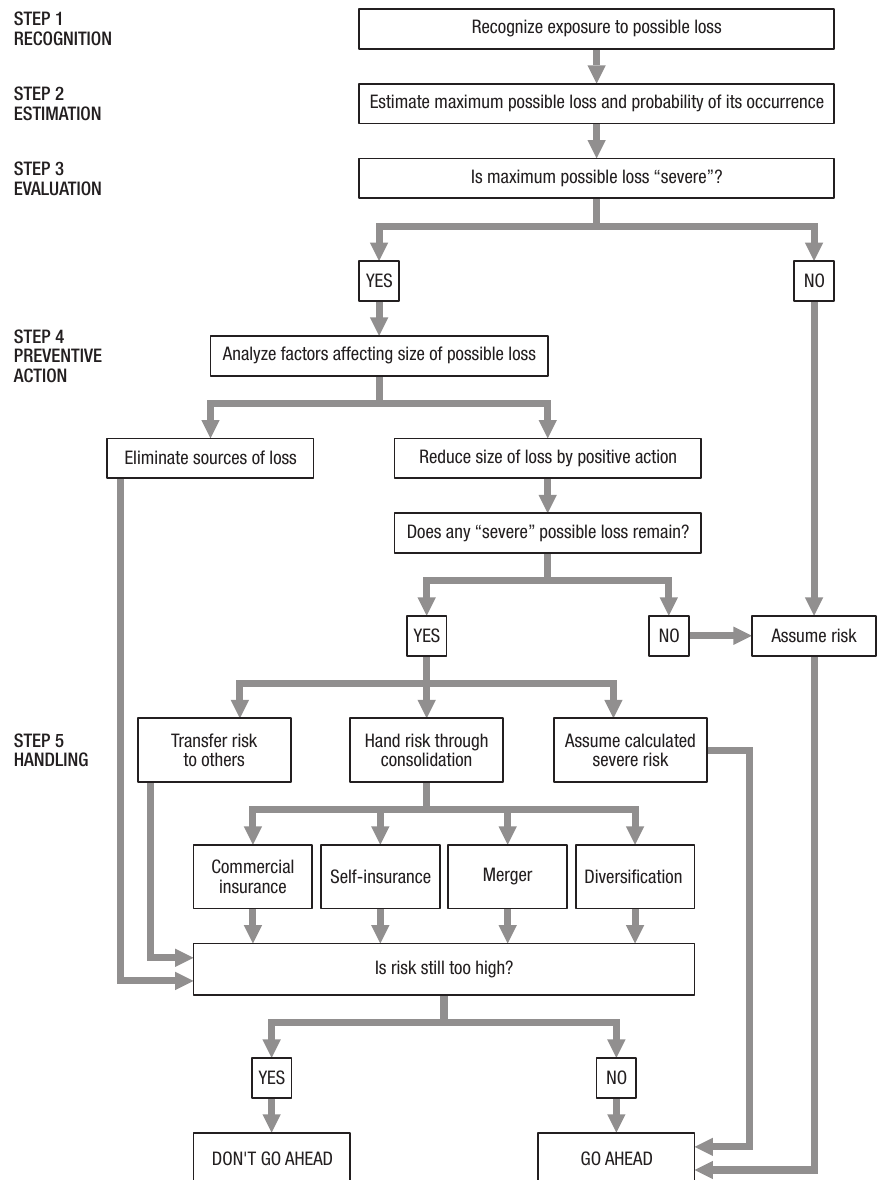
Fig. 1. Logic fl ow chart for marketing risk decisions (Greene